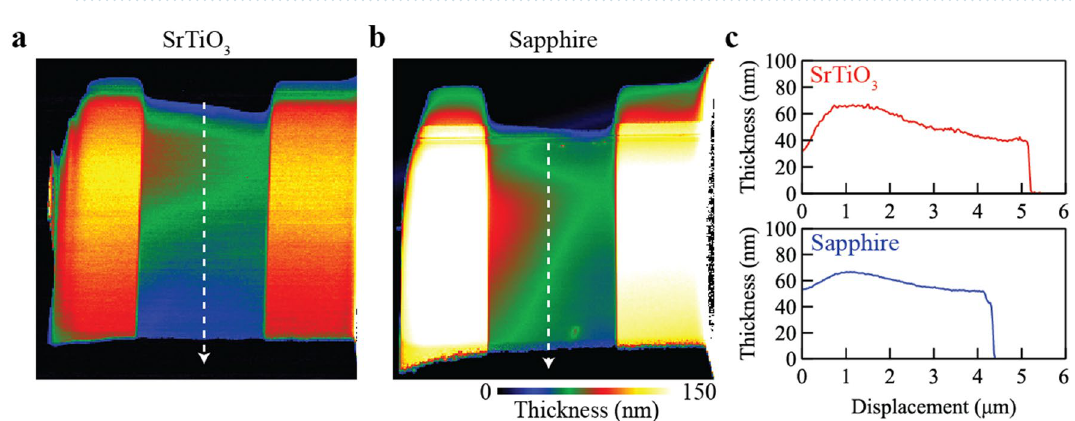
Figure 5. Sample thickness of SrTiO 3 and sapphire lamellae prepared by the optimized robotic FIB. ( a,b ) Thickness maps from low loss EELS spectrum imaging of SrTiO 3 and sapphire, respectively. ( c ) Thickness profiles from the top protective layer to the bottom